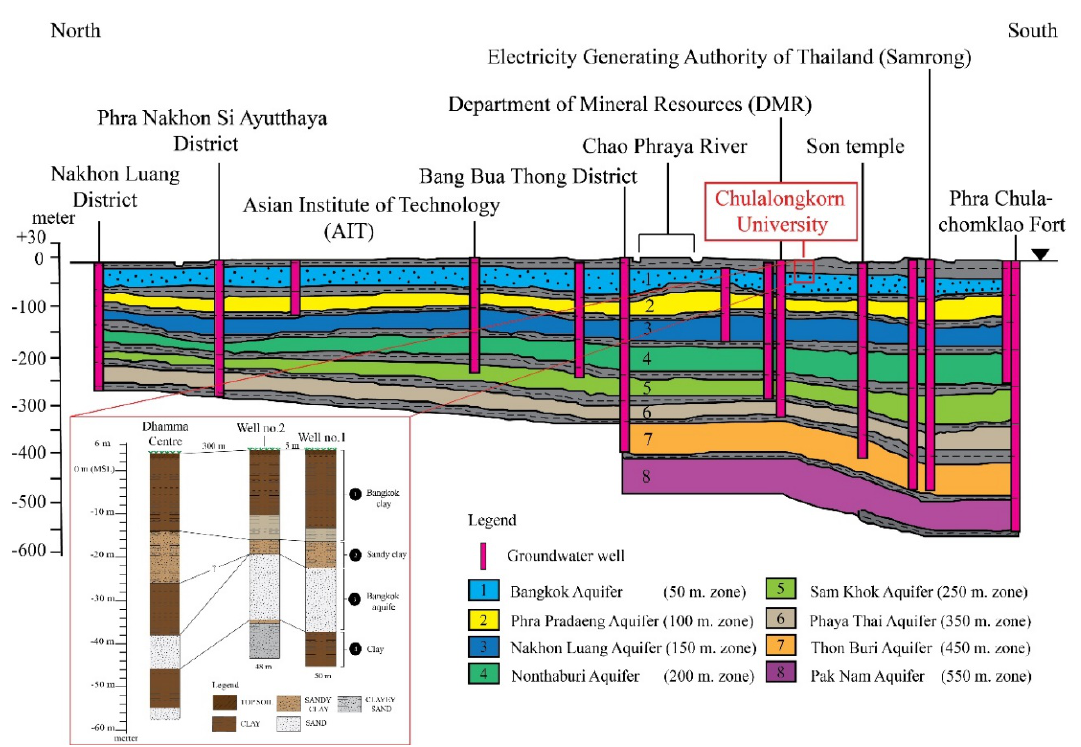
Figure 2. Subsurface stratigraphy and aquifer of the Lower Chao Phraya Plain (modified after Department of Mineral Resources [22]).